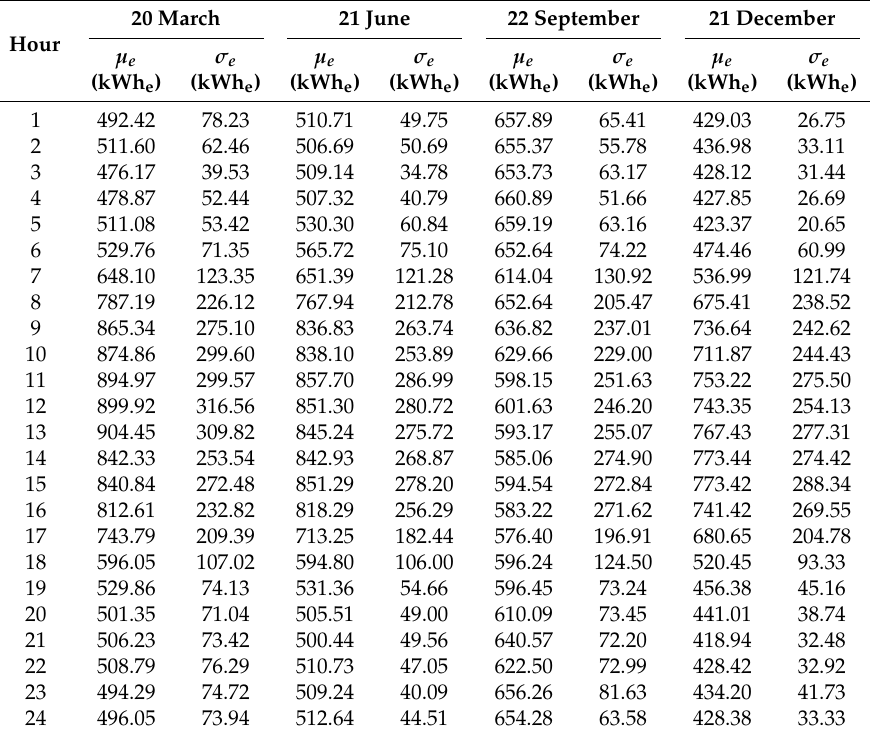
Table A1. Electricity load parameters (mean and standard deviation) on four different days.